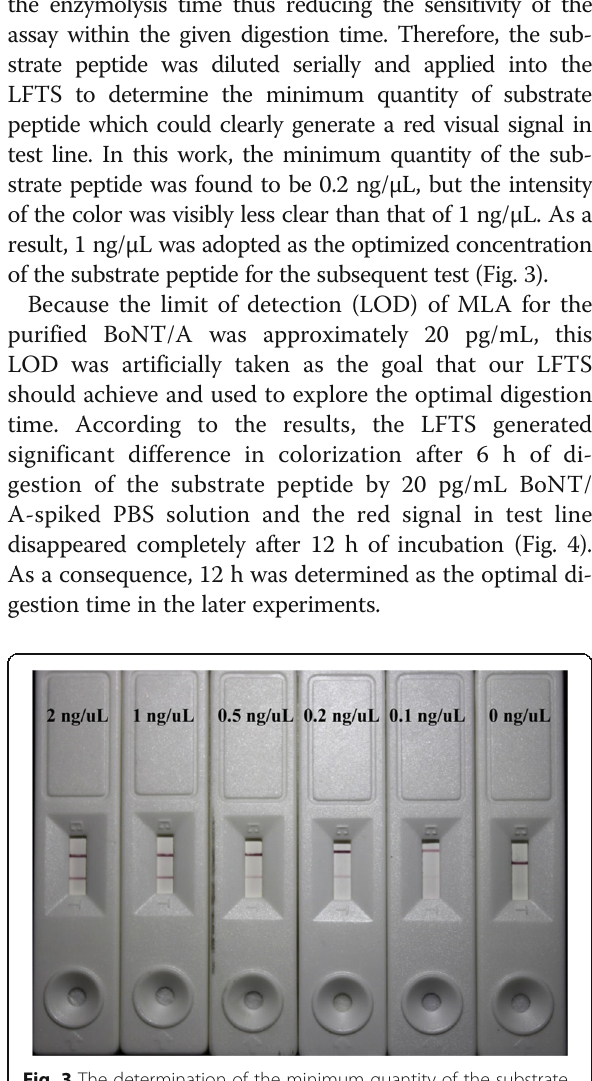
Fig. 3 The determination of the minimum quantity of the substrate peptide. The concentrations of substrate peptide used in the experiments were from 0 to 2 ng/ μ L ( from right to left )